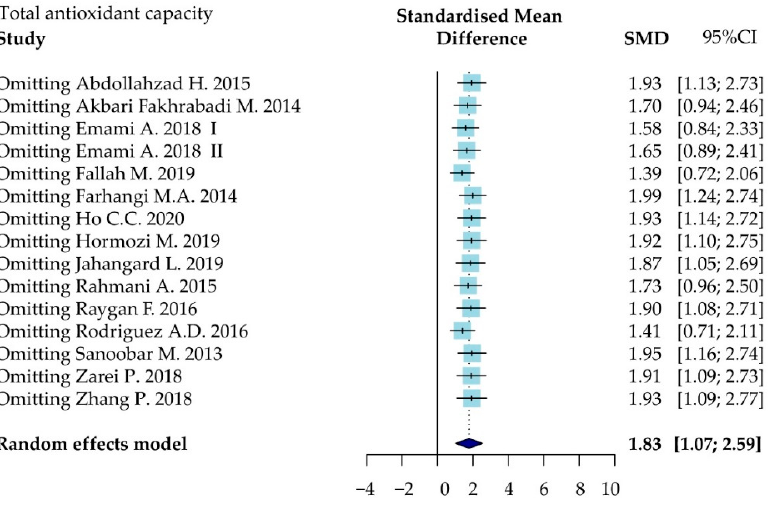
Figure A2. Sensitivity analysis for the effects of CoQ10 on TAC through removal of individual trials one by one.